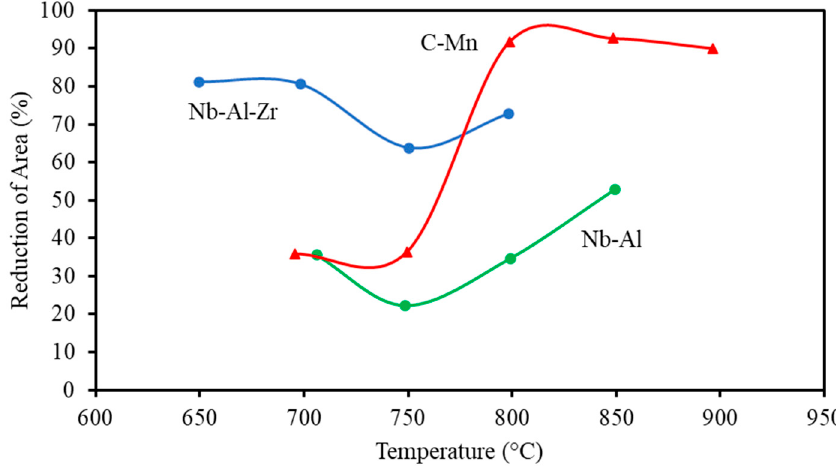
Figure 20. Hot ductility curves for plain C-Mn, C-Mn-Nb-Al, and C-Mn-Nb-Al-Zr steels. Tensile samples were solution-treated at 1330 °C, then cooled to the test temperature at 60 °C/min and strained at a rate of 3 × 10 − 3 s − 1 [108], with the permission from Taylor & Francis, 2023.